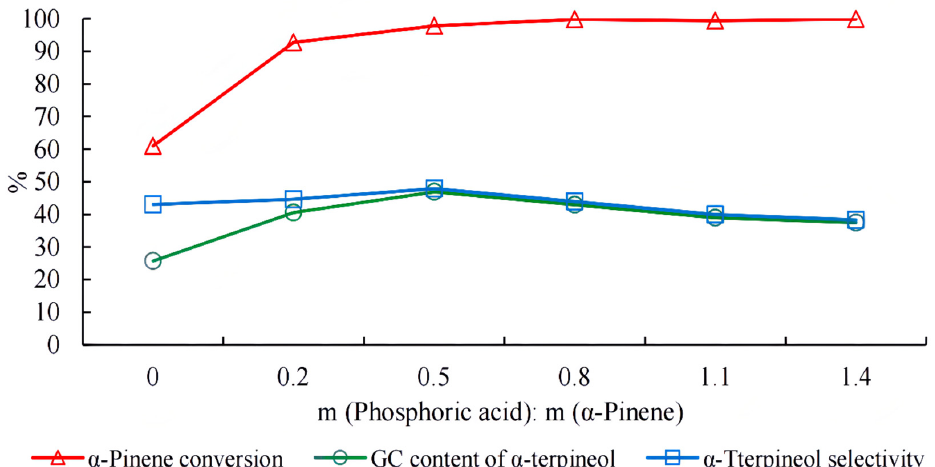
Figure 8. Effect of phosphoric acid dosage on the hydration of alpha-pinene. Note: The mass ratio of alpha-pinene, water, acetic acid, and citric acid was 1:1:2.5:1 for 15 h.